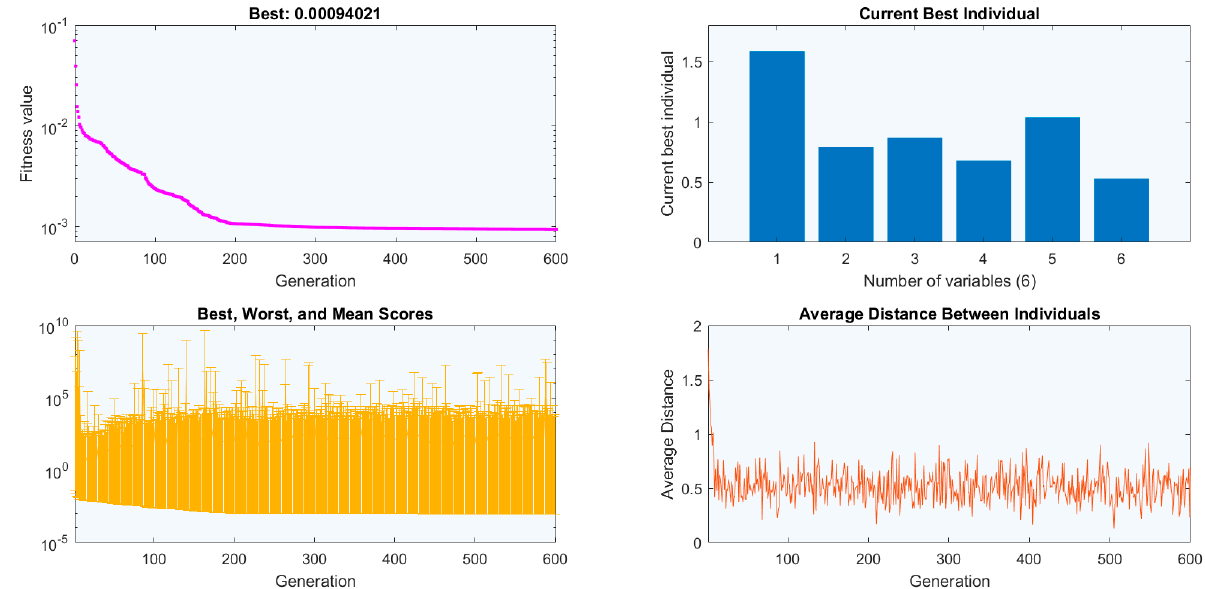
Figure 4. Results of Problem 1 in terms of learning curve, best individual scores, and average distance for 0.01 noise level.